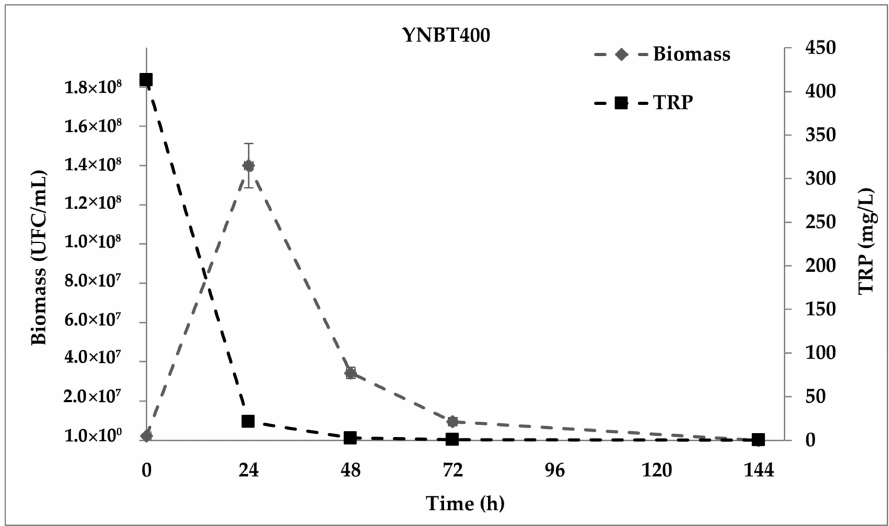
Figure 4. S. cerevisiae EC1118 growth curve in YNBT400 medium and TRP consumption.